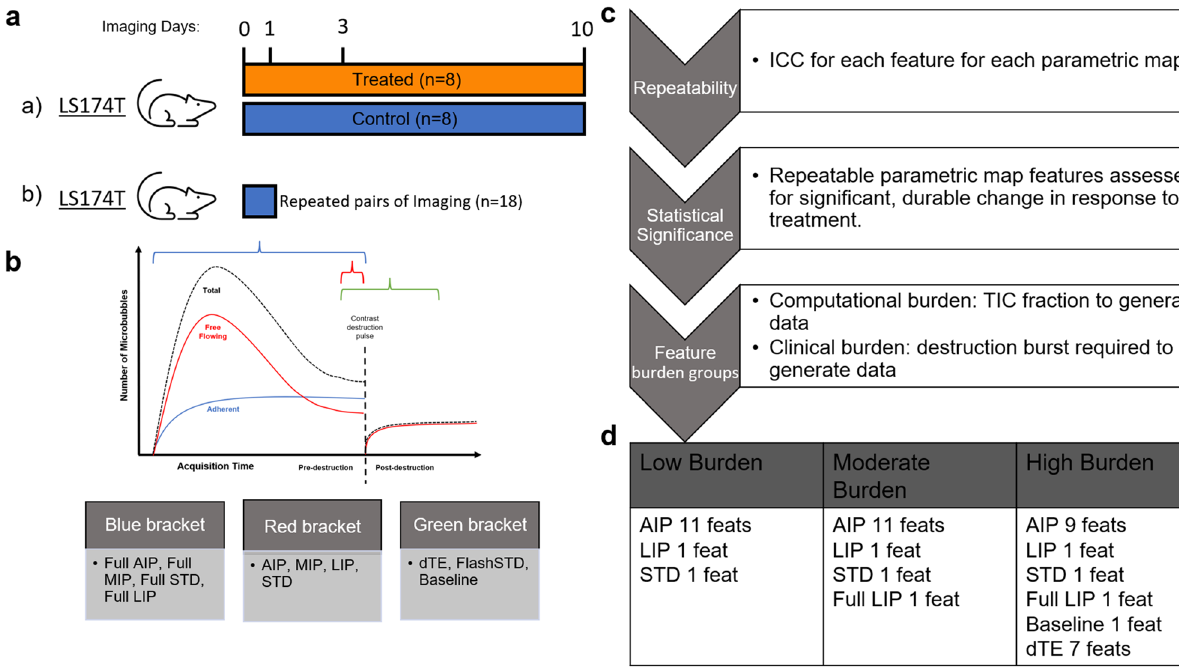
Figure 1. AIP Average intensity projection, MIP maximum intensity projection, dTE differential targeted enhancement, STD standard deviation, LIP lowest intensity projection, ICC intra-class correlation coefficient, TIC time-intensity curve. Overview of feature extraction and selection process. ( a ) Schematic summary of US imaging data acquisition and mouse cohorts. ( b ) Representative TIC for molecular imaging showing the fraction of acquired cine frames from which intensity maps are derived. ( c ) Stepwise statistical feature selection process leading to formation of feature sets stratified by burden of computational requirement and/or necessity of destruction US pulse. ( d ) Summary of image feature sets based on expected clinical burden for obtaining after statistical feature selection and correlation